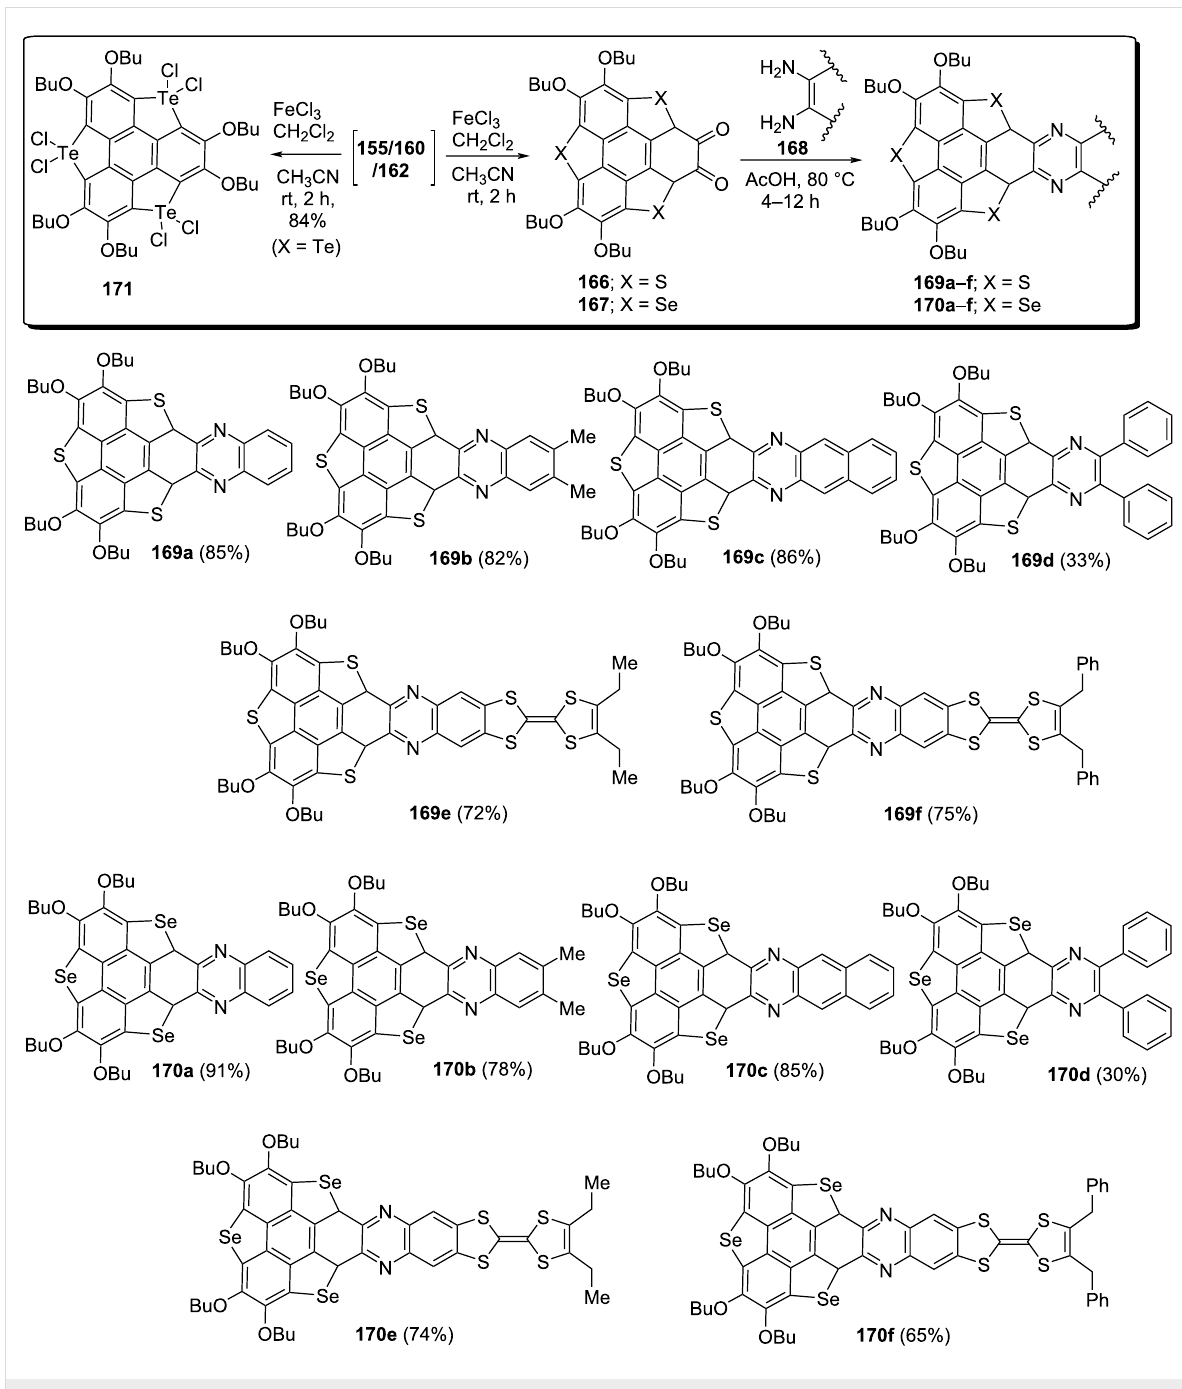
Scheme 44: Synthesis of pyrazine-fused sumanene architectures through condensation